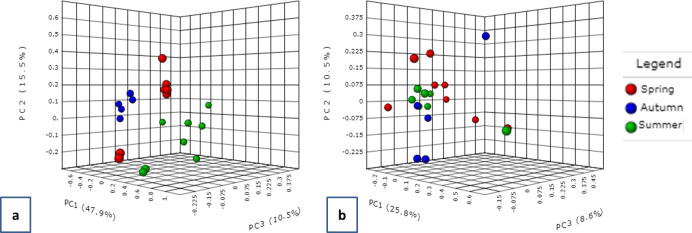
Beta diversity clustering based on PCoA on the Bray Curtis distances of (a) bacterial and (b) fungal genus distributed during the three seasons in Kuwait. The colours represent the three seasons blue (autumn); red (summer); green (spring).